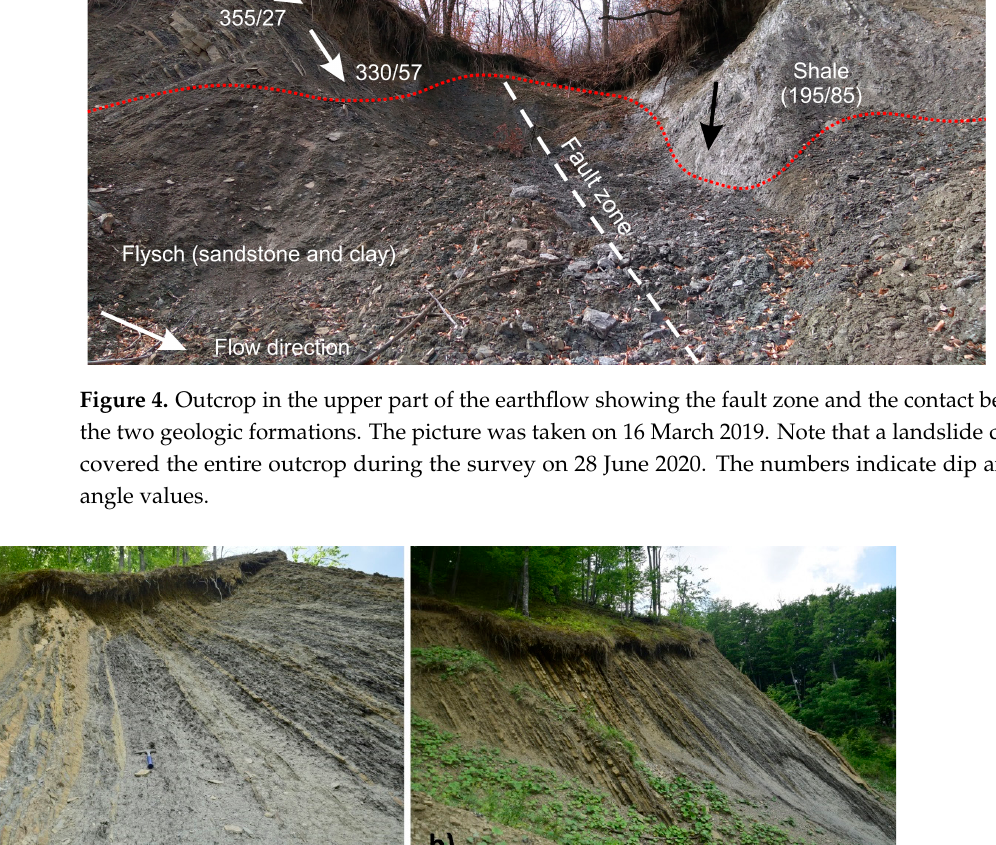
Figure 5. Secondary headscarps of the Chirle ș ti earth fl ow. The pictures were taken on 16 March 2019: ( a ) view of the main scarp from downslope to upslope; ( b ) view of the main scarp from pro- fi le.